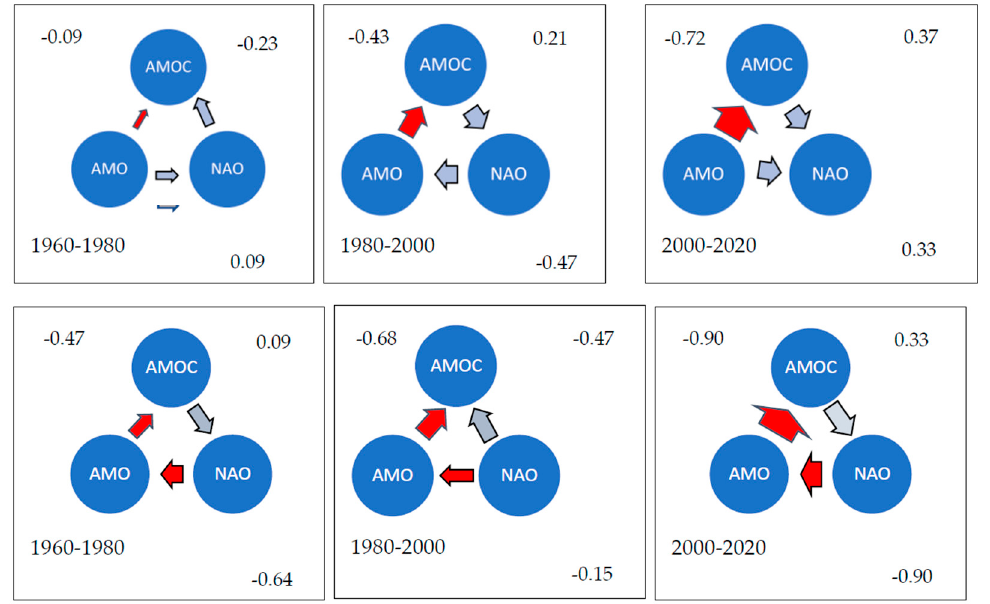
Figure 7. LL relations between the AMOC, the AMO, and the NAO: LL(AMOC,AMO), LL(AMOC, NAO), LL(AMO,NAO). AMOC is measured in Sverdrup, Sv; AMO is measured in temperature degrees; and NAO is measured in sea-level pressure, hPa. We have distinguished three periods corresponding to the LL patterns in Figure 2. The arrows indicate leading directions, and arrow thickness indicates leading strength, Equation (2). The numbers in each corner show numerical values for direction (LL(x, y) > 0: x → y. The leading strength is the average for the ten mid-years in each period. Upper row : high-frequency oscillations. Lower row : low-frequency oscillations. Red arrows suggest that the leading role is persistent across all time periods.